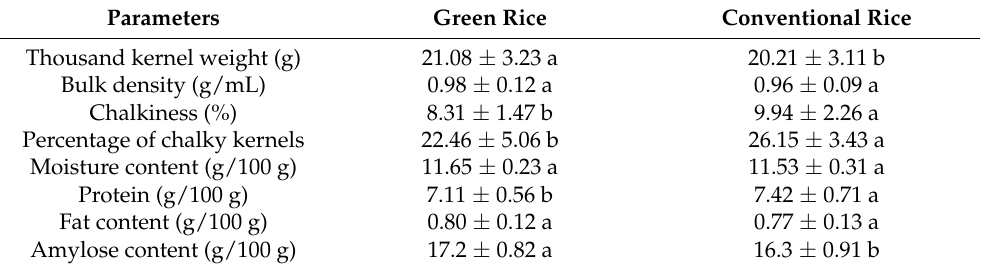
Fat content (g/100